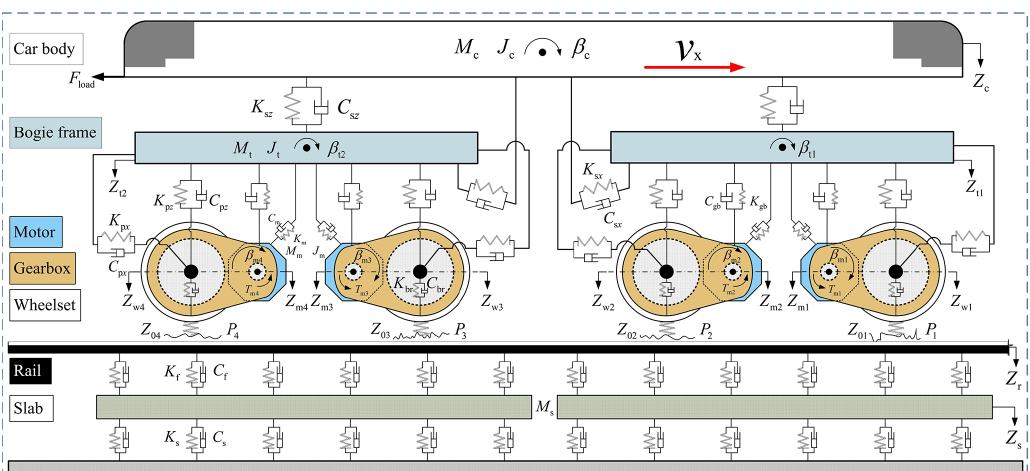
Figure 1. Vehicle–track coupled dynamics model of a metro vehicle with traction motors and gear transmissions.